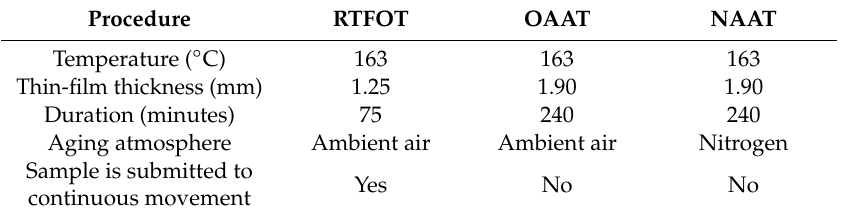
Table 4. Parameters of aging procedures (rolling thin-film oven test (RTFOT), ambient atmosphere oven aging test (OAAT), and nitrogen atmosphere oven aging test (NAAT)).